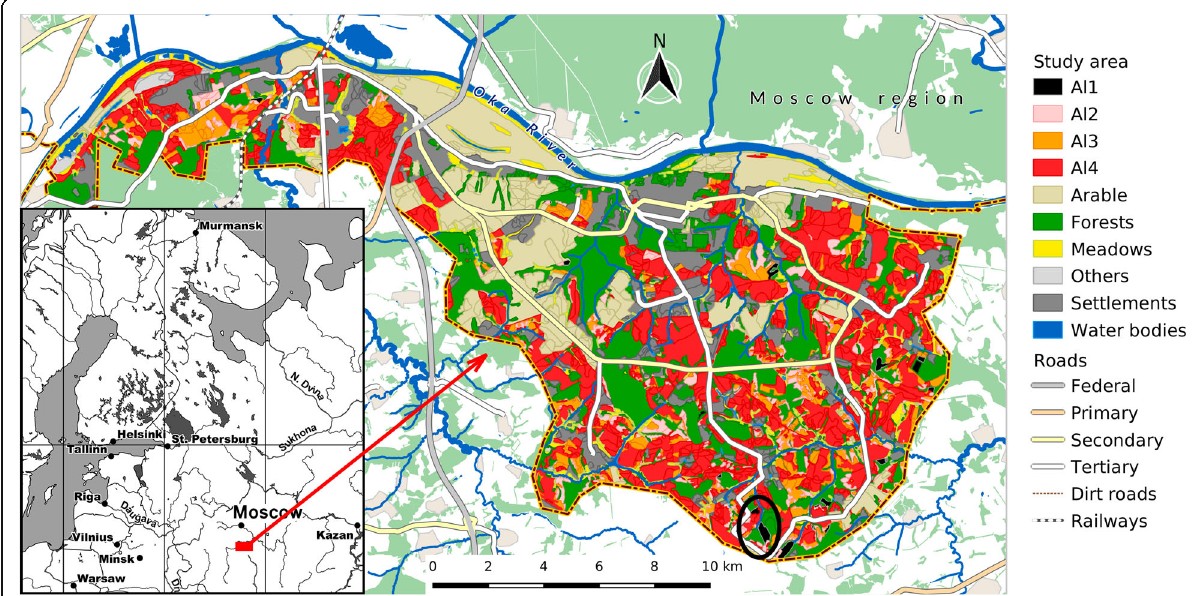
Fig. 1 Map of the study area with land types. Al1, Al2, Al3, and Al4 are abandoned arable lands which differ in coverage of their woody vegetation: Al1 with a uniform tree cover, Al2 with a dense tree cover in spots, Al3 with a tree cover of small density, and Al4 without trees or with a few single trees. “ Forests ” includes the categories “ Forest ” and “ Sparse forest ” of Table 1. The black circle surrounds the study area at the local